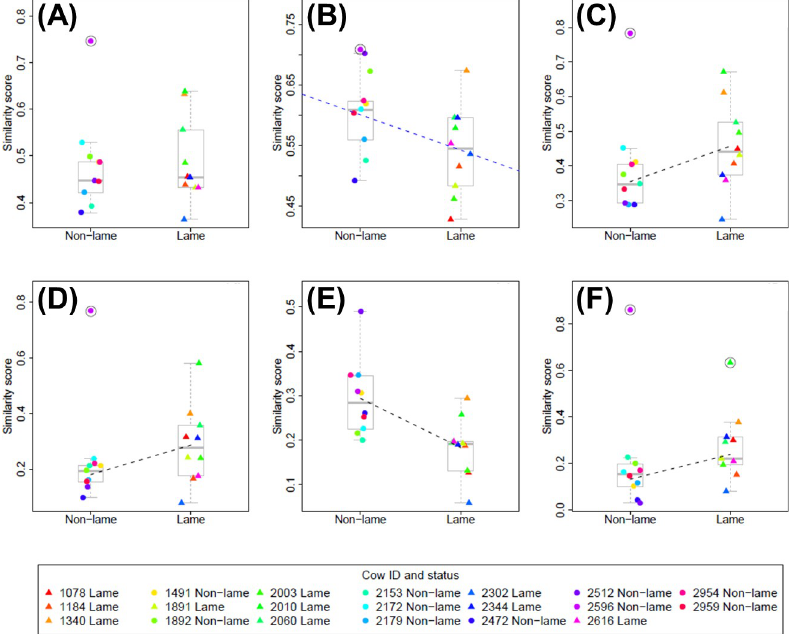
Fig 4. Plots showing relationship between significant predictor variables (lameness; parity; days in milk, DIM) and site-fidelity similarity measures. Data for each site-fidelity similarity measure, S to (F) respectively, and are plotted against lameness status (which is the most significant predictor variable determined from the model selection procedure (Table 1), in all cases except (A), where no predictor variable is significant). Boxplots are used to show the spread of the data for the non-lame and lame groups, and individual data points are calculated as a mean average across all five days of the trial for each cow (S3 Table). Lame cows are plotted as filled triangles and non-lame cows as filled circles; the colours used to indicate each data point are fixed for each cow and are consistent across all plots (see legend). In (C-F), where the best fitting linear model includes only a single predictor variable, the fitted regression line is shown as a dashed black line. In (B) the best fitting linear model includes both lameness and DIM terms (Table 1); a regression line fitted only to the lameness variable (the most significant predictor) is shown as a blue dashed line for illustrative purposes only. In (A-D) and (F) the outlier cows (2596 and 2010) are marked with a black ring. Outlier cows were not included in the data for the purposes of model fitting (except for (E), where no outlier cows were removed from the